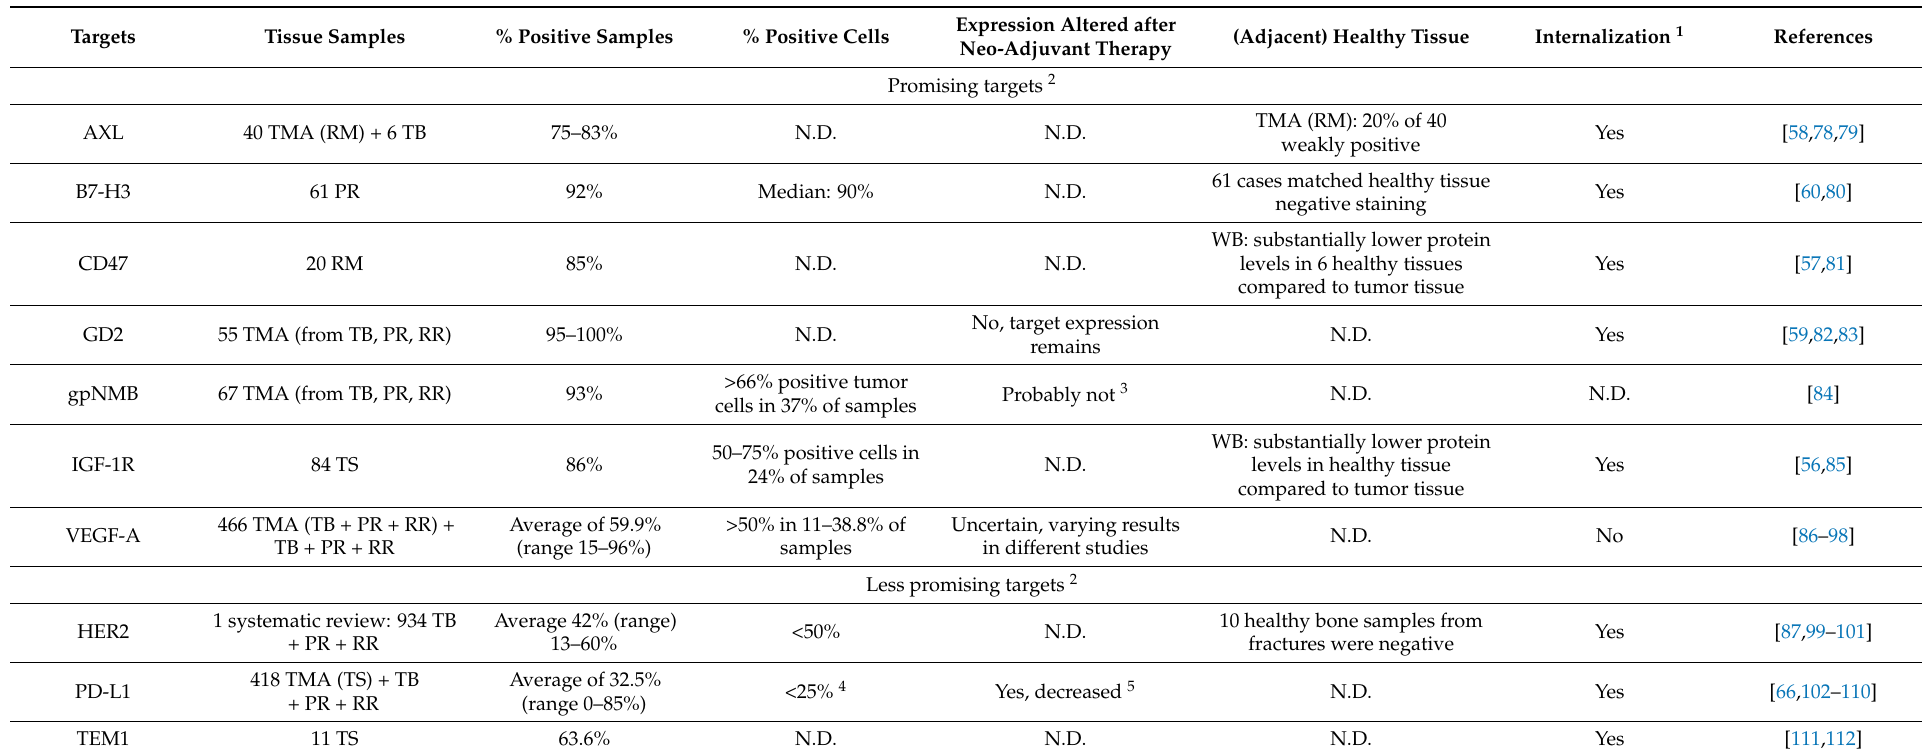
Table 2. Characteristics of targets evaluated for fluorescence-guided surgery in